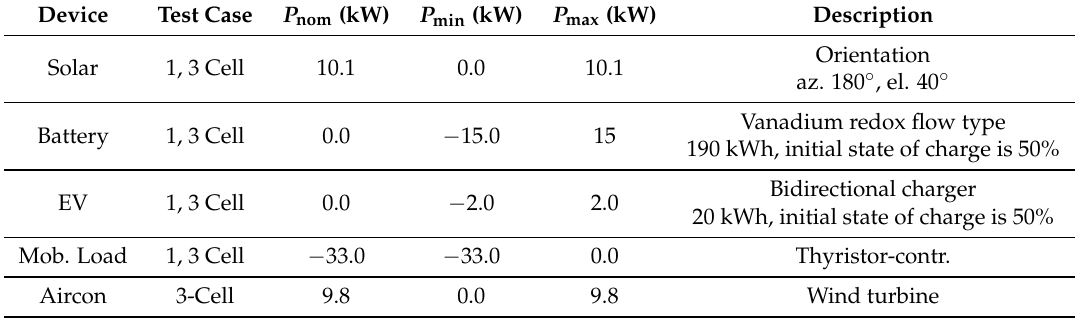
Table 2. Properties of devices used in the one-cell